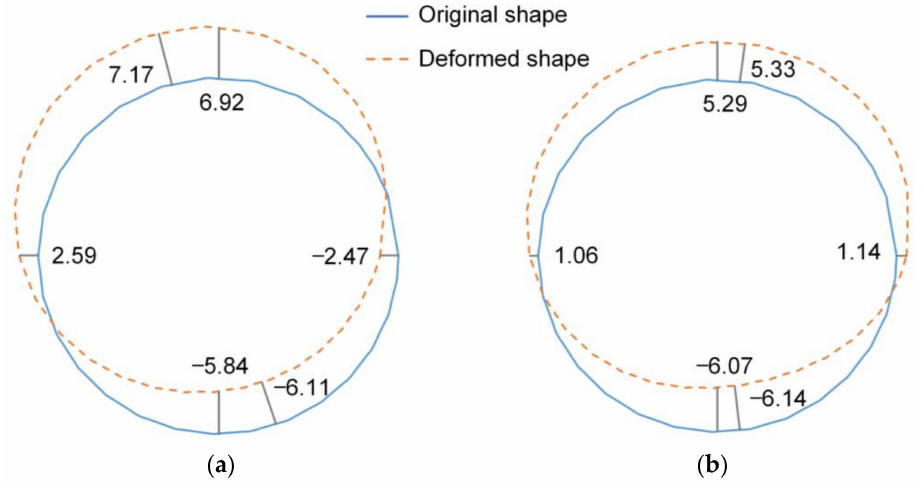
Figure 21. Displacement of the inner line of the upper stay ring (mm): ( a ) non-circle case; ( b ) circle case.